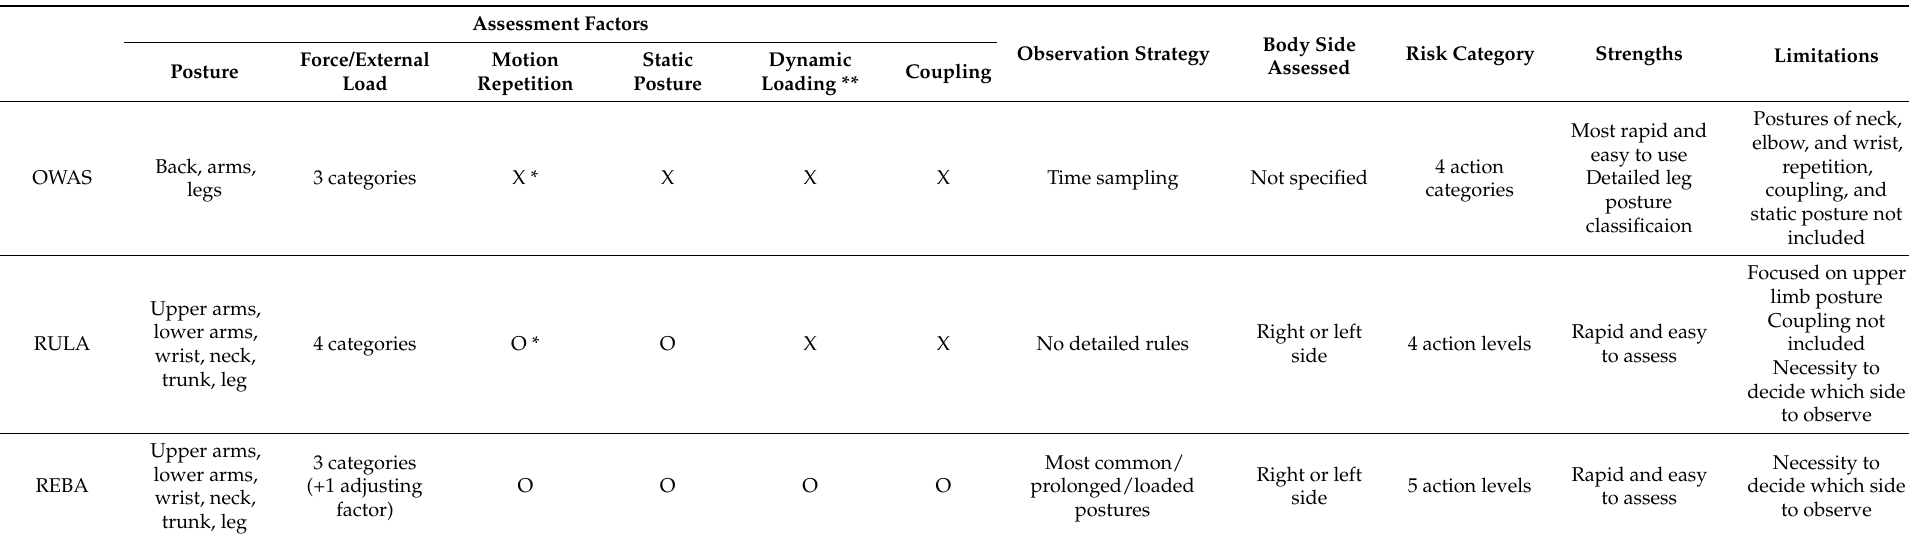
Table 1. General characteristics of OWAS, RULA and